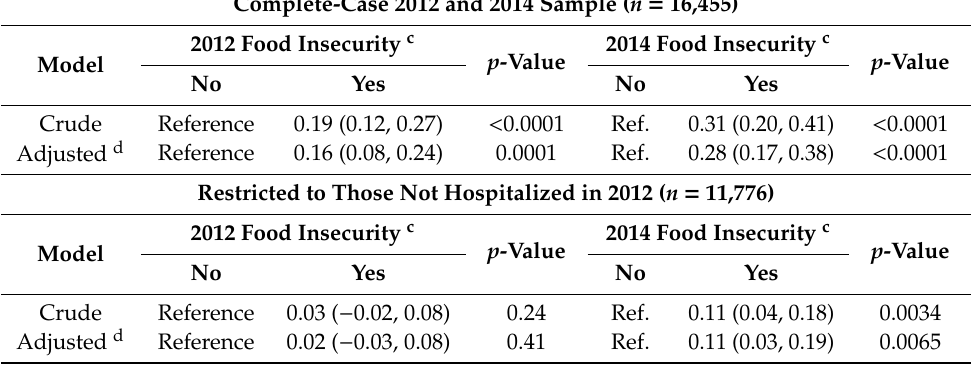
Table 3. β ’s and 95% confidence intervals for the association between food insecurity and standardized hospitalizations frequency a,b